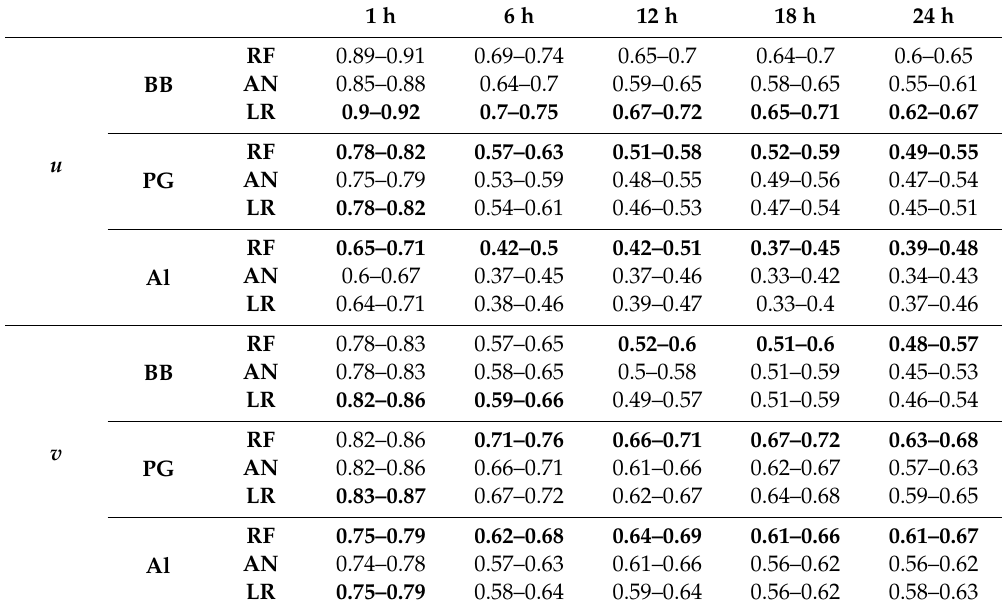
Table 3. R 2 verification index of u and v wind components for the steps 1, 6, 12, 18, and 24 h, for three locations (Bilbao Bizkaia, Punta Galea, and Alegria), and three statistical methods (random forest, analogs, and linear regression). The best verification values are typed using bold